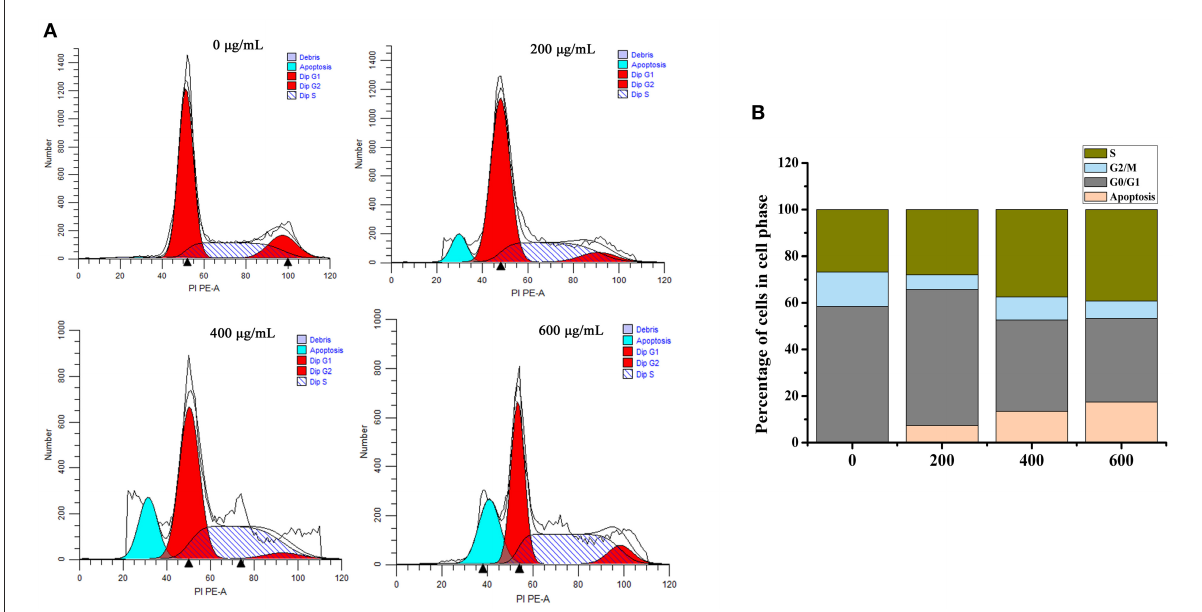
FIGURE9 Effects of SVPS2 on cell cycle distribution of HT-29 cells. (A) The percentage of HT-29 cells in each cell cycle phase after treatment with SVPS2. (B) Proportion chart of each cycle.